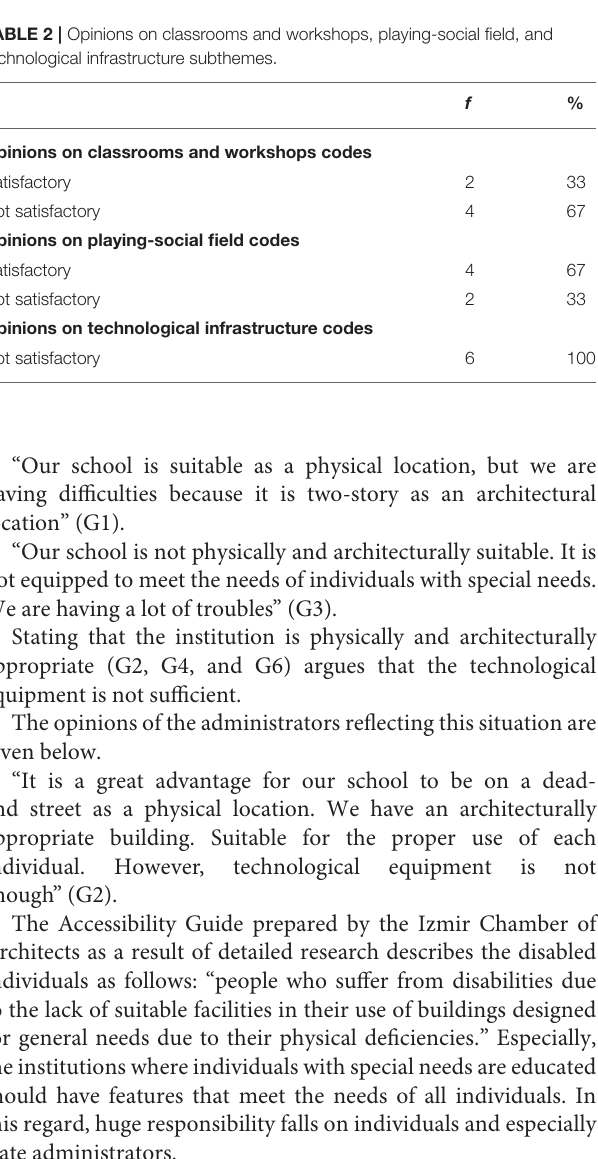
TABLE 2 | Opinions on classrooms and workshops, playing-social field, and technological infrastructure subthemes.